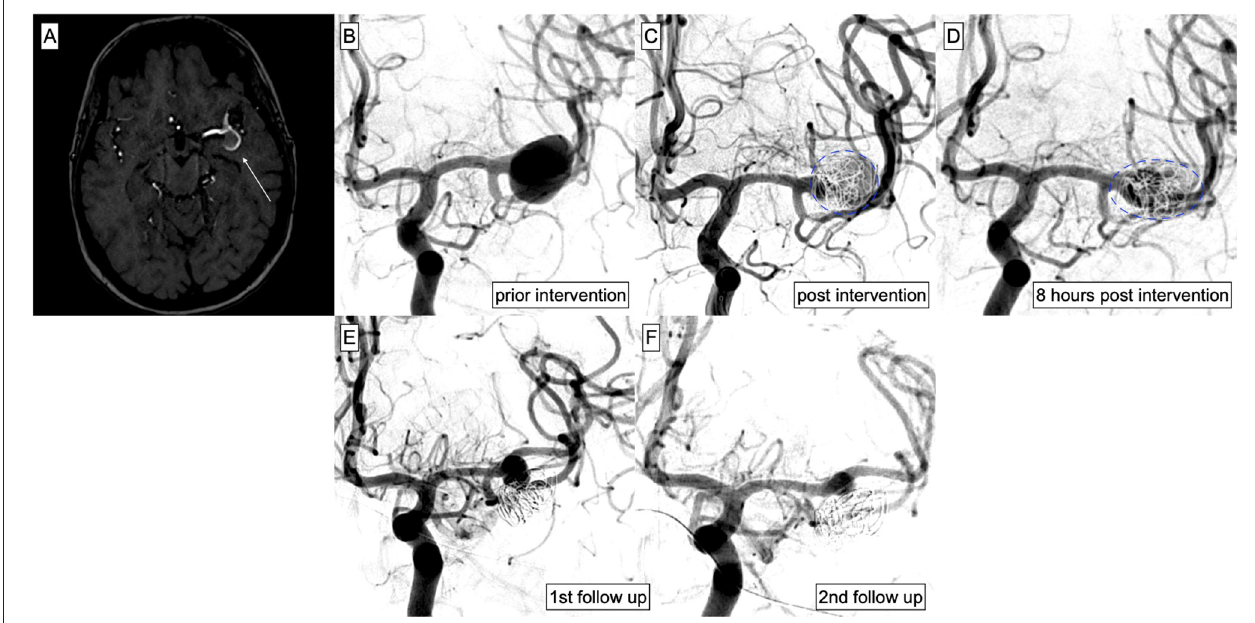
FIGURE 3 | Endovascular treatment of an MCA aneurysm on the left side. MRI was performed due to fluctuating aphasia and hemiparesis. (A) Time of flight angiography revealed the aneurysm (white arrow) located at the left MCA bifurcation measuring 15mm × 14mm × 11mm. (B) DSA confirmed the broad-based aneurysm. The patient refused open surgery and decided for endovascular treatment. (C) The aneurysm had grown 2mm in size and its morphology had changed within 24h, justifying again the prompt treatment by indicating a highly unstable situation. Therefore, decision was made for immediate protective coiling and flow diversion. The SVB was successfully implanted after loose coiling of the aneurysm sac (proximal landing zone: M1, distal landing zone: superior branch of the MCA bifurcation). (D) Eight h post intervention, the patient developed increasing hemiparesis of the left side. DSA was performed to exclude potential stent occlusion. The vessel proved patent; however, the morphology of the aneurysm and the coil package had changed again (highlighted in blue), indicating inflammatory changes of the aneurysm. Anti-inflammatory medication was given and the patient’s symptoms resolved completely within 5 days. (E) The first regular follow-up 3 months post-treatment revealed a stable situation and decrease of the perfused aneurysm part/lumen. (F) One month later, DSA was performed again to decide on the further course of anti-inflammatory therapy. The perfused part of the aneurysm had further decreased and anti-inflammatory medication was